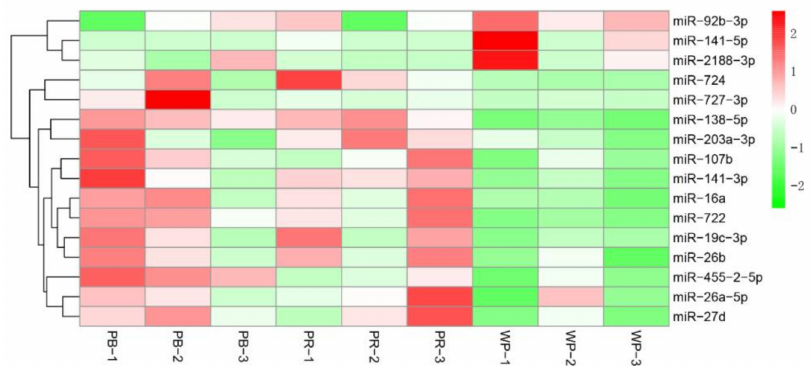
Figure 3. The expression pattern of 16 differentially expressed miRNAs (DEMs) related to pigmentation process. From green to red, the expression value ranged from low to high expression.